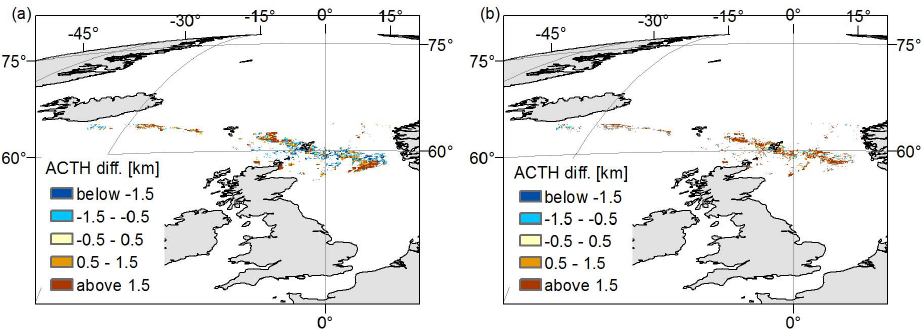
Fig. 12. Differences between the valid ACTH of the ash plume and the standard MODIS top height product (a) and results of the BT method (b) on 15 April at 11:35UTC (our ACTH are shown in Fig. 8a).